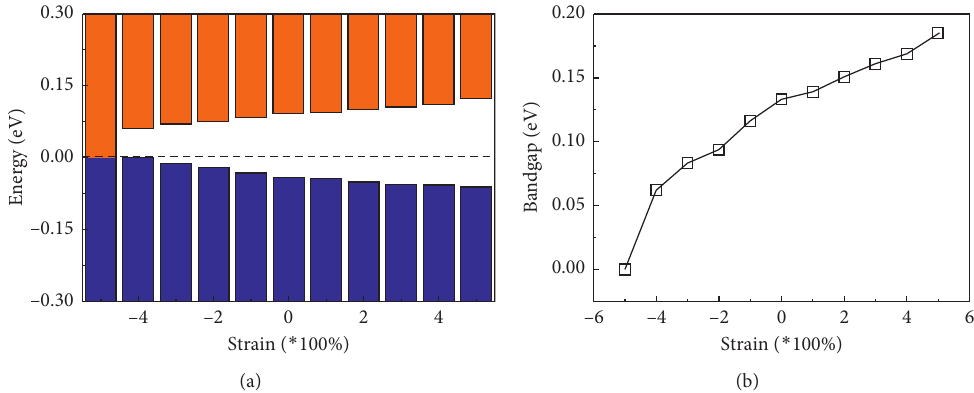
Figure 4: Graphs showing (a) the band edge and (b) the bandgap as a function of the strain strength that is applied to the silicane/SnSe